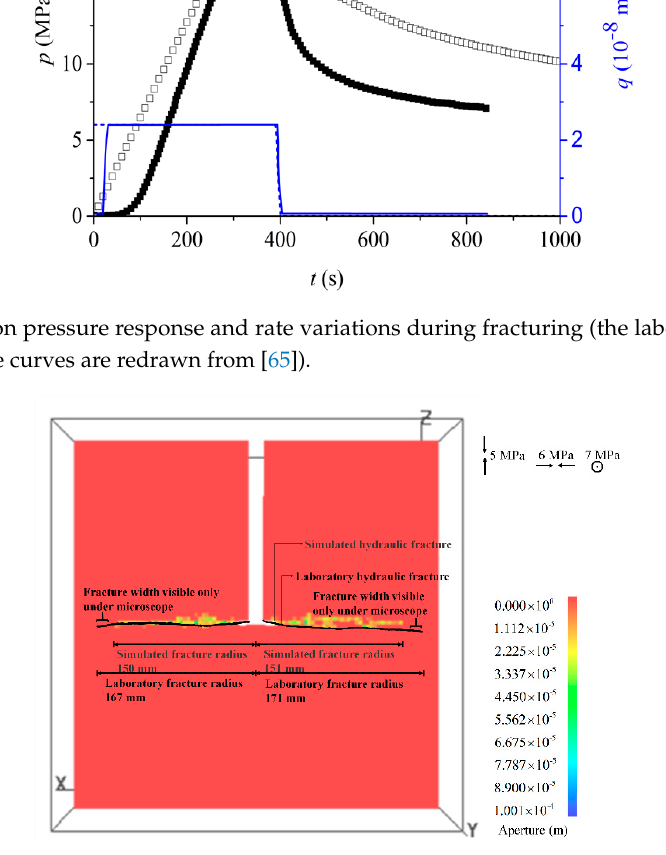
Figure 3. Fracture propagation paths obtained from “single completion” laboratory test [6 5 ] and RFPA-Petrol analysis. RFPA-Petrol